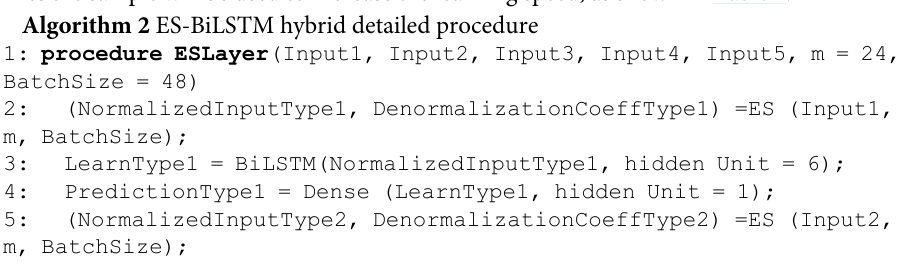
Algorithm 2 ES-BiLSTM hybrid detailed procedure